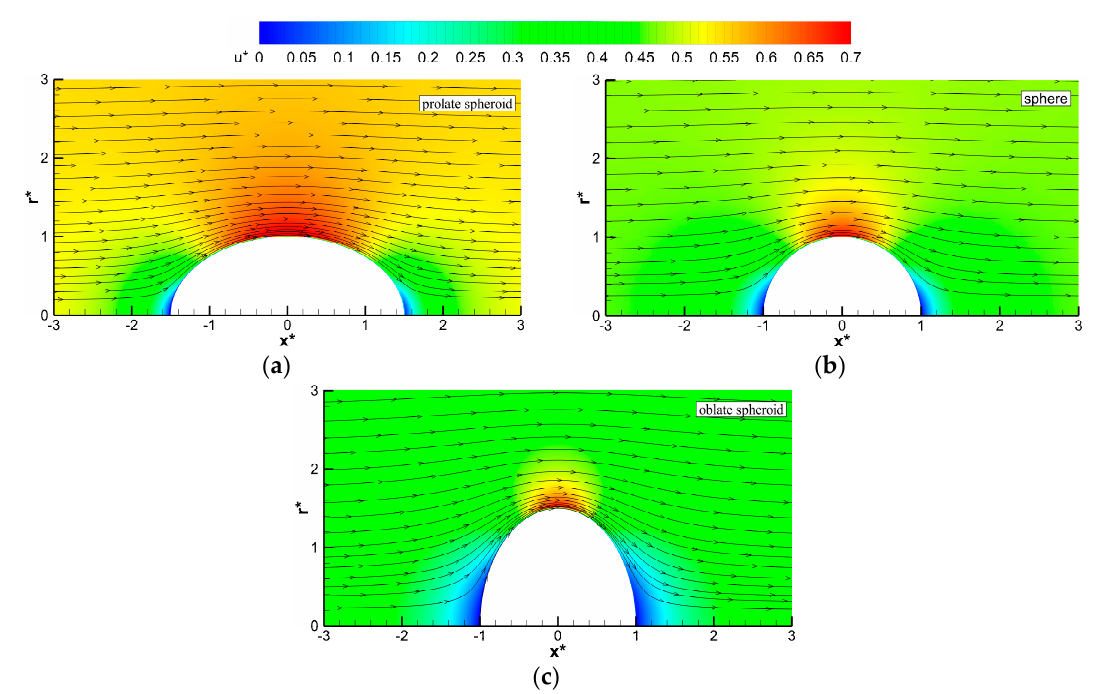
Figure 2. Distributions of the dimensionless axial velocity around the particles when κ a = 100 for different spheroidal particles: ( a ) prolate spheroids with b / a = 1.5, ( b ) sphere with b / a = 1, and ( c ) oblate spheroids with b / a = 1.5. The solid lines with arrows denote the streamlines.